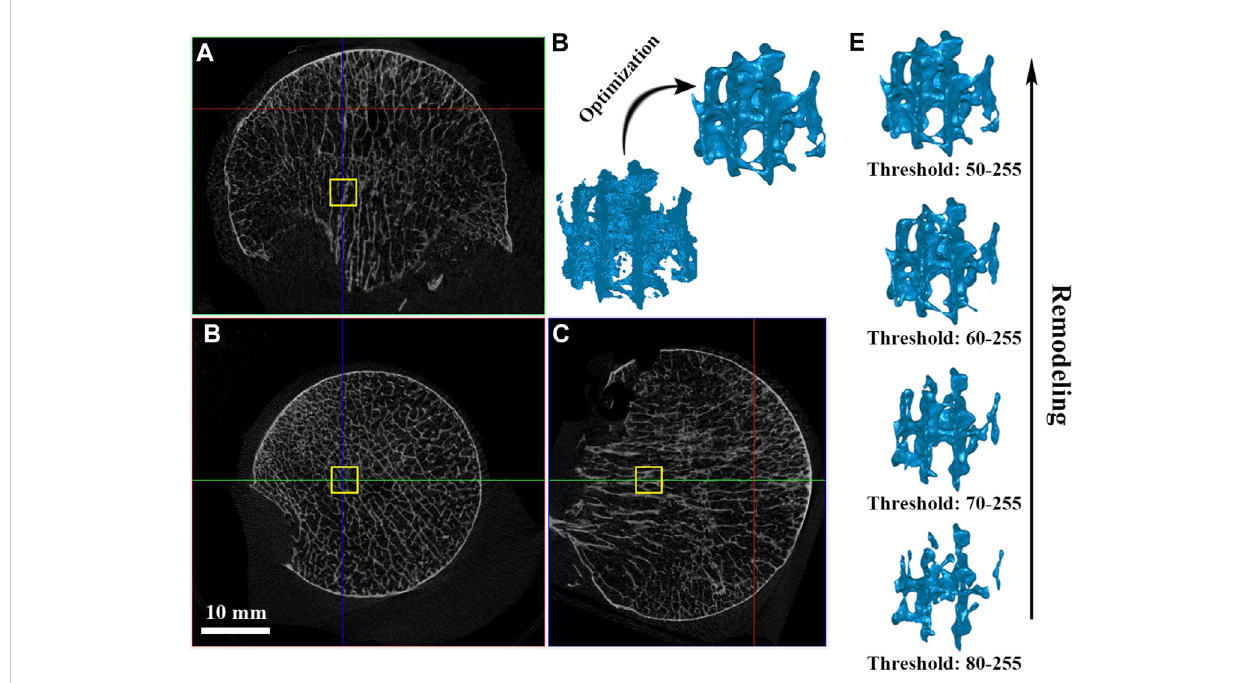
FIGURE 1 VOI trabeculae segmentation and simulating bone remodeling. (A – C) A cube of dimension 3 × 3 × 3 mm was taken as the volume of interest (VOI) from thedomain of thefemoralhead; (D) Model optimizationmanagement; (E) Simulating individual trabecularbone remodeling bychanging theglobal